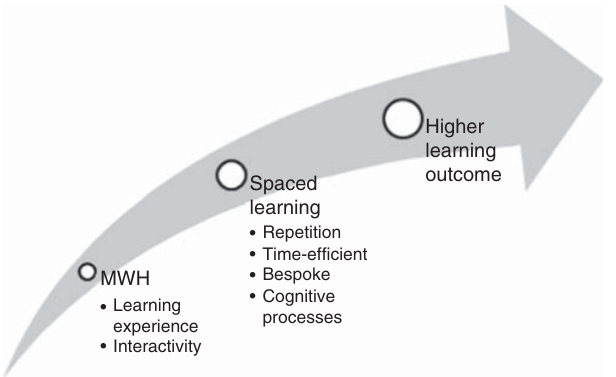
Figure 5. SL impact on